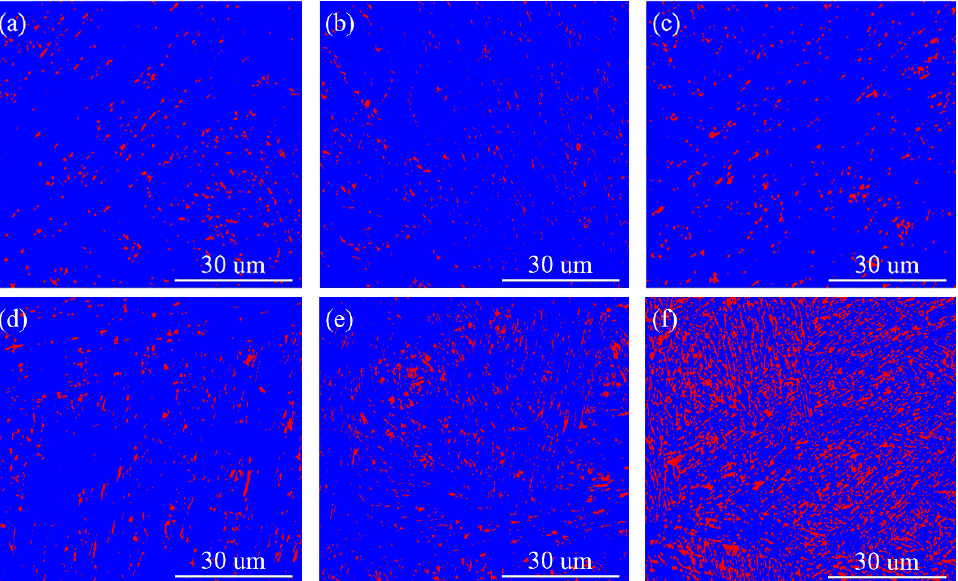
Figure 17. EBSD phase diagram of specimens under various thermal conditions. The blue area is the martensitic matrix, and the red area is the austenitic structure: ( a ) DC, ( b ) 480A-0.5, ( c) 540A-0.5, ( d ) 540A-4, ( e ) 540A-80, and ( f ) 600A-80.